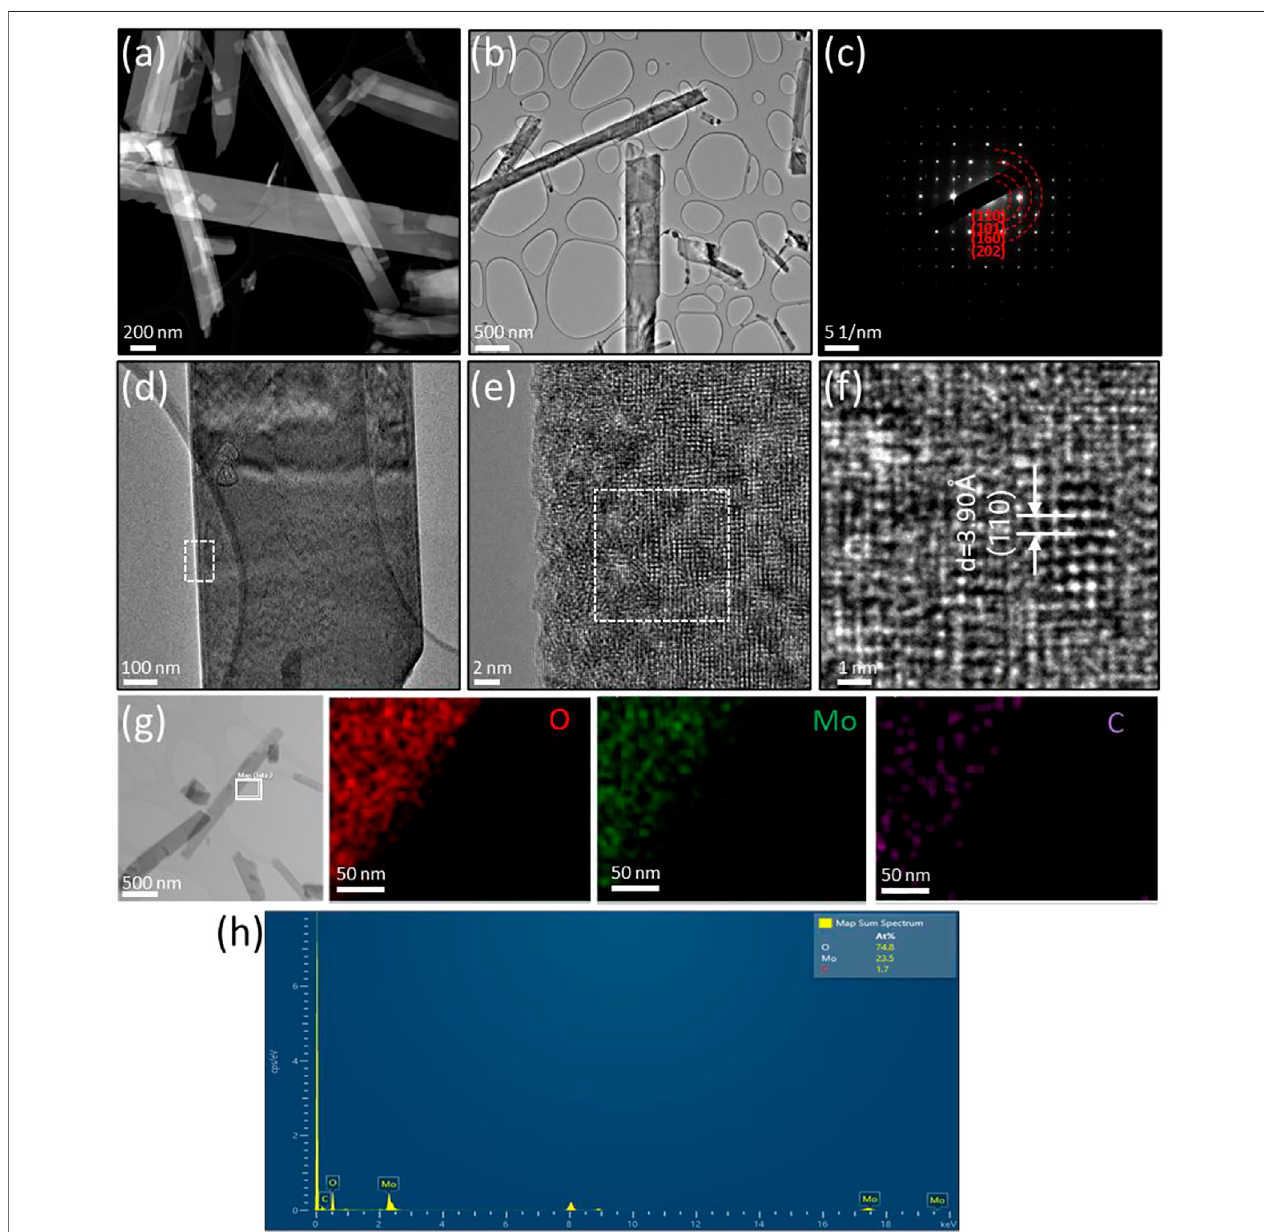
FIGURE5| StructuralcharacterizationofHT-MoO 3 /C. (A) HAADF-STEMimage. (B) TEMimage. (C) SAEDpattern (D – F) HRTEMimageoftheareamarkedbythe white box in (D) . (G – H) TEM-EDS mapping and spectroscopy of the area marked by the white box in (G) .